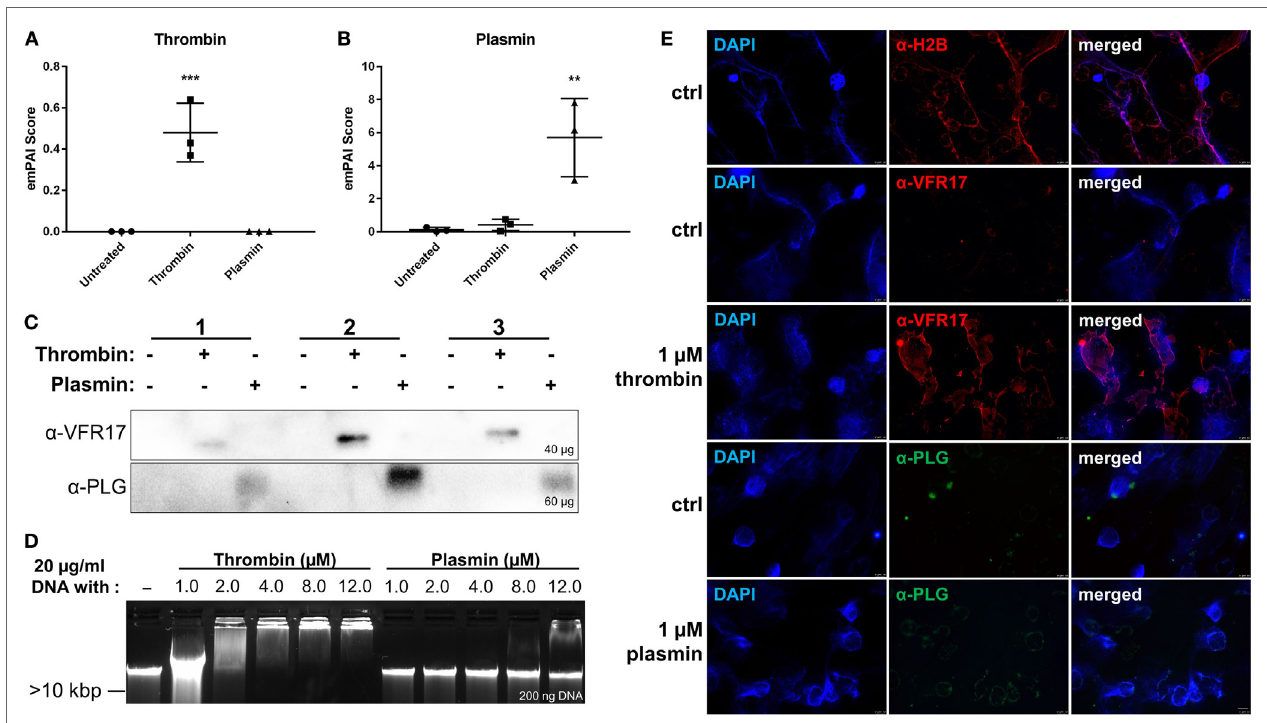
FigUre 3 | Analysis of neutrophil extracellular trap/DNA-binding of thrombin and plasmin. The raw exponentially modified protein abundance index (emPAI) scores from + DNase samples of (a) thrombin and (B) plasmin were compared across the treatment conditions ( n = 3). (c) Western blot analyses on + DNase samples for α -VRF17 (~37 kDa; upper panel ) and α -PLG (~40 kDa; lower panel ). Amounts of proteins loaded were as indicated in the figure. (D) DNA (20 µg/ml) was either incubated alone or with 1.0, 2.0, 4.0, 8.0, or 12.0 µM of thrombin or plasmin in Rose Park Memorial Institute for 1 h at 37°C. Then, 200 ng of DNA was loaded onto 0.5% agarose gel for gel electrophoresis. (e) Polymorphonucleated cells were treated with PMA only ( ctrl ) for 4 h at 37°C or added with 1 µM thrombin or plasmin after 2 h with PMA. First row : α -H2B (red); second and third row : α -VFR17 (red); fourth and fifth row : α -PLG (green). Scale bar: 10